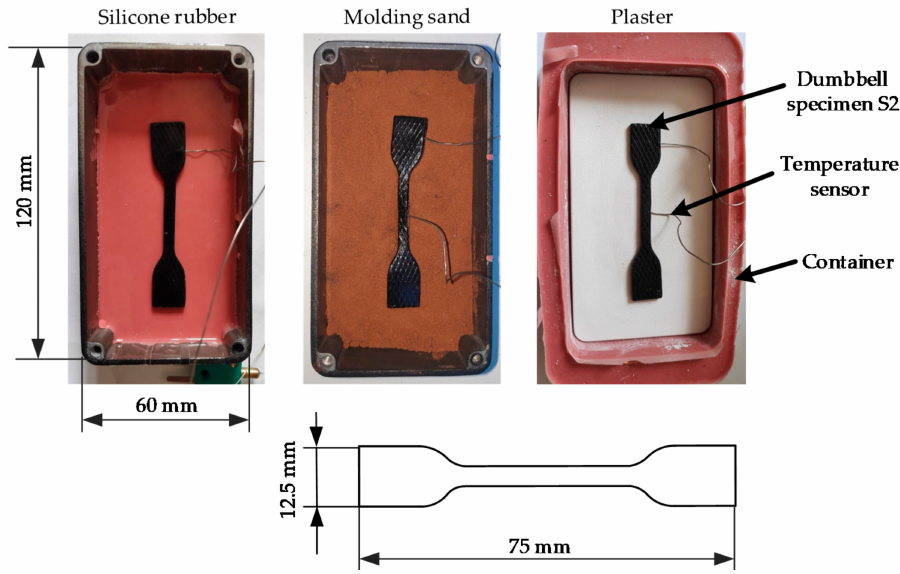
Figure 2. Dumbbell specimen with temperature sensors on 10 mm base layers of